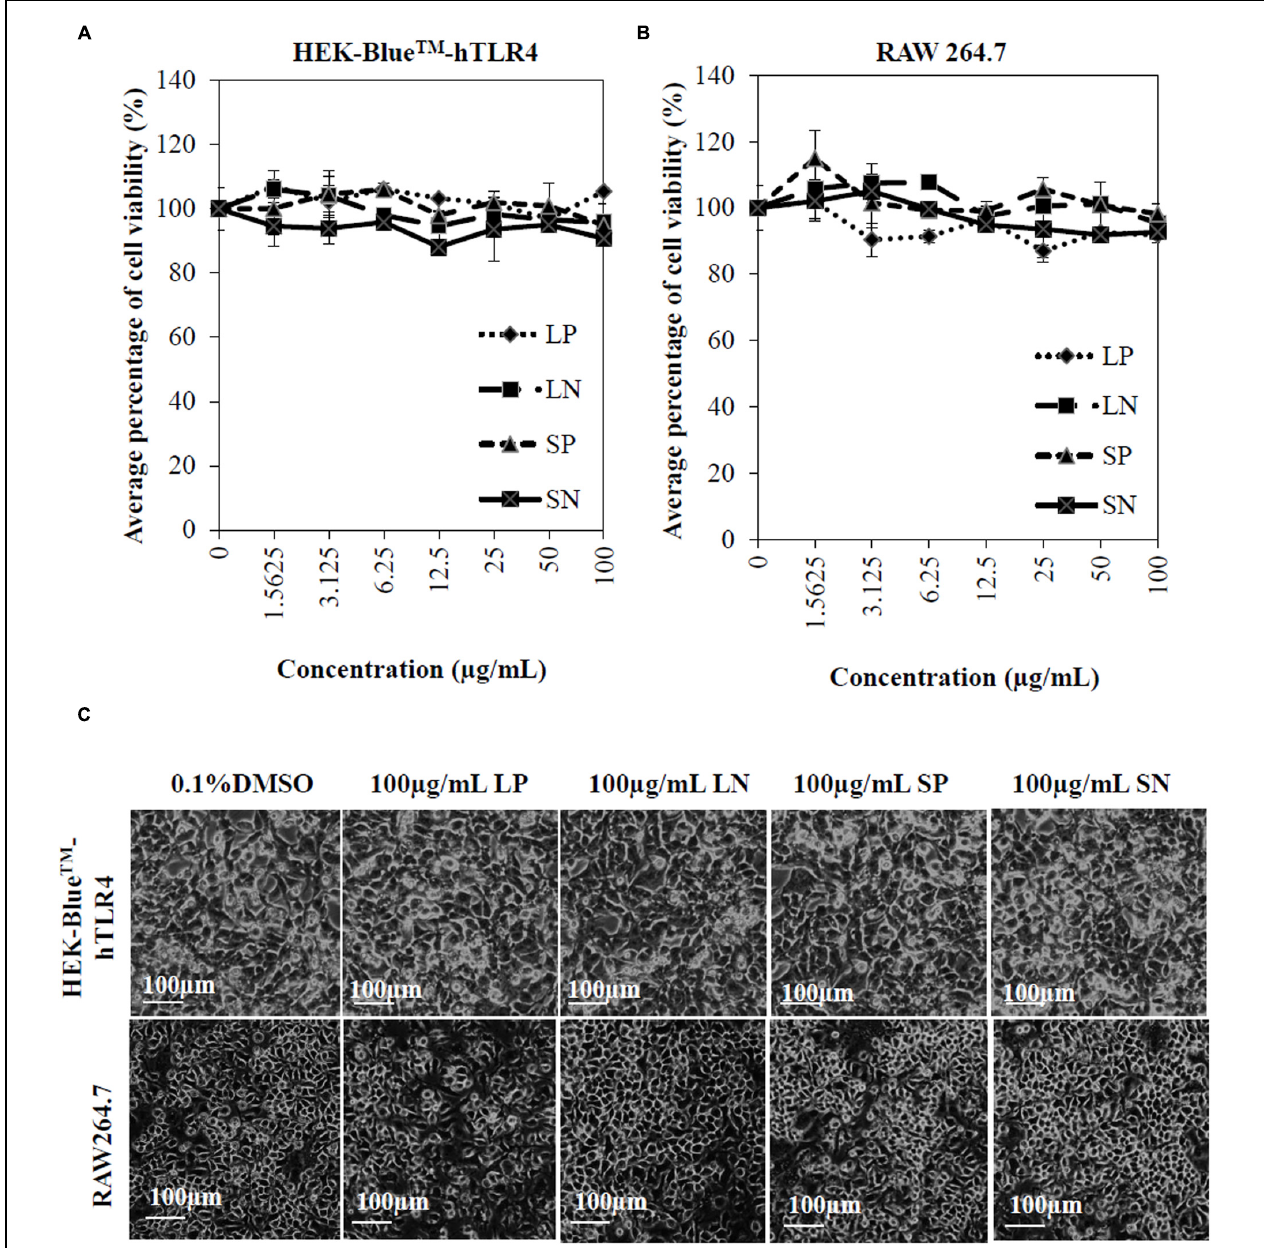
FIGURE 1 | Cytotoxicity of Clinacanthus nutans extracts on cells. Dose response curve of LP, LN, SP, and SN on cell viability of human embryonic kidney cells, HEK-BlueTMhTLR-4 (A) and murine macrophages, RAW264.7 (B) . All values were not significant difference when compared to 0.1% DMSO (one-way ANOVA post hoc Dunnett’s t -test). Each value represents means ± SD from three independent experiments. (C) No significant morphological changes in HEK-BlueTMhTLR-4 and RAW264.7 cells after 72 hours treatment with 100 μ g/mL of extracts or 0.1%